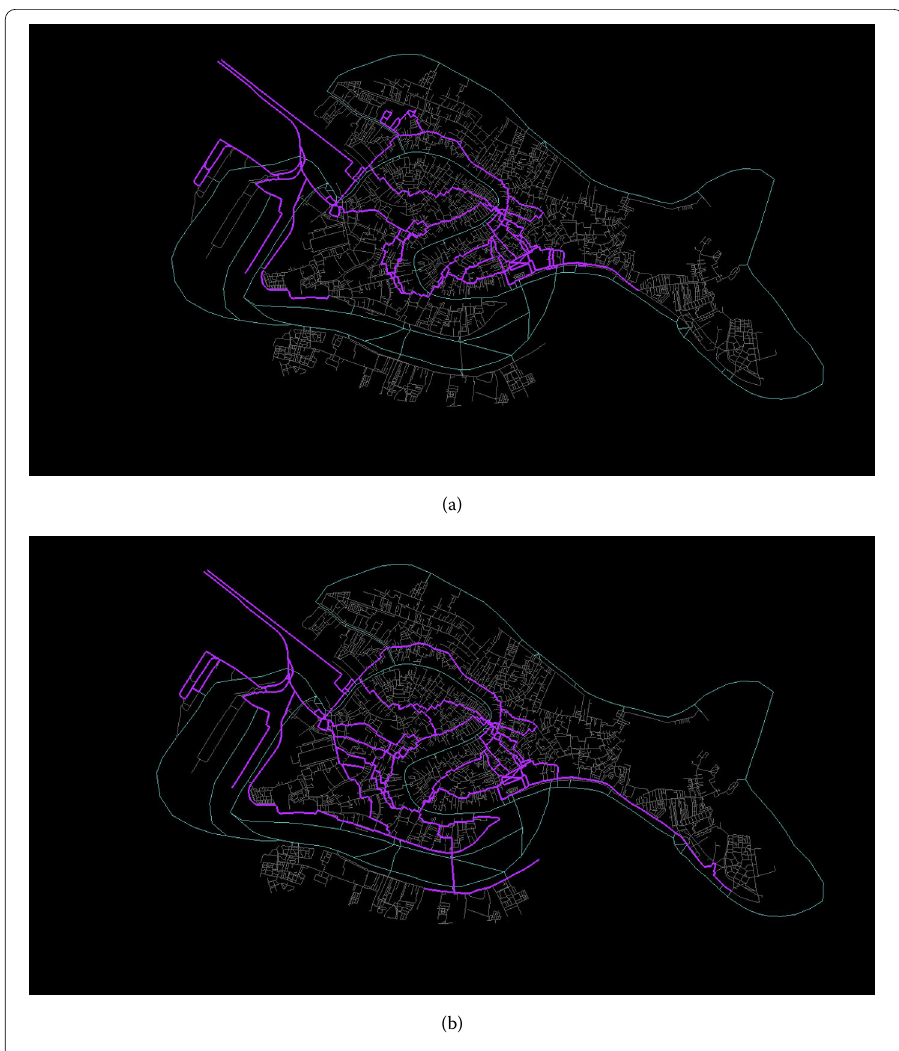
Figure 8 Picture (a): selected subnetworks (highlighted in blue) from the road network of the Venice historical centre (in the background), that explain 64% of the recorded mobility in the datasets. The top picture refers to the Carnival mobility during 26/02/2017 and corresponds to 13% of the total length of the Venice road network. The picture (b) refers to the FesatdelRedentore mobility during 15/07/2017 and corresponds to 15% of the total length of the Venice road network